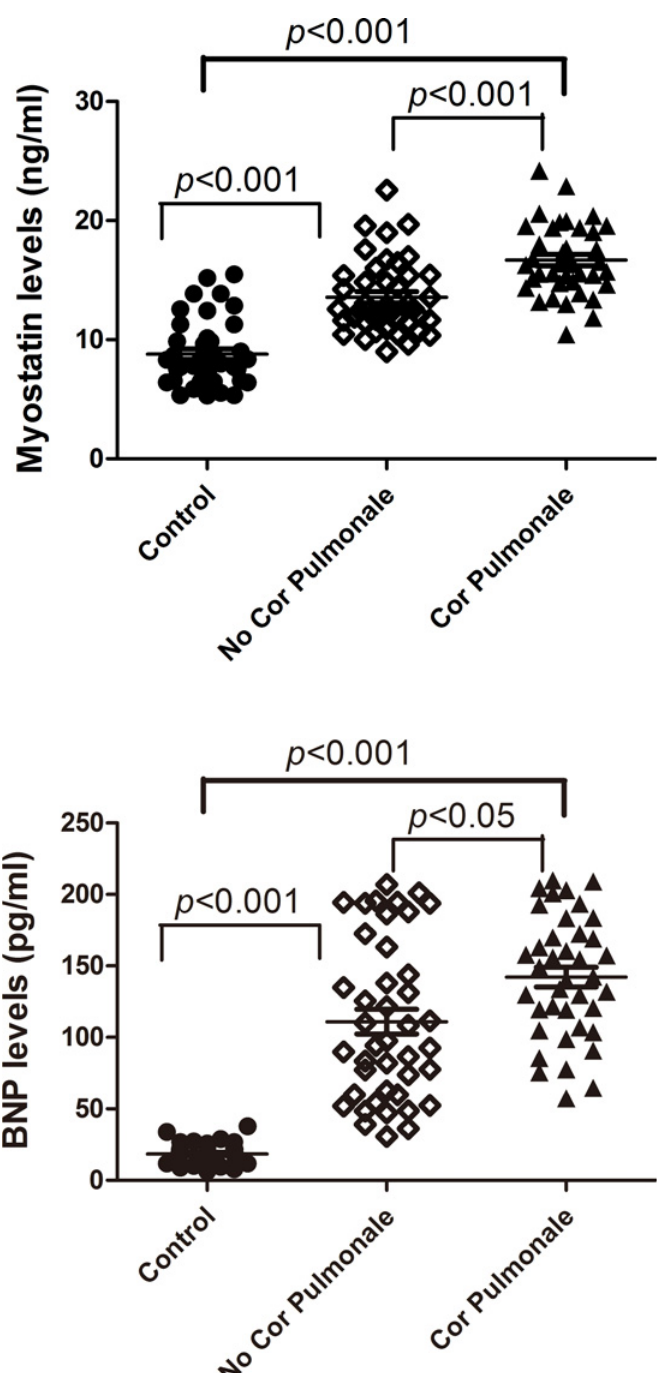
Fig 1. Fig 1(A) and (B). Comparison of myostatin and B-type natriuretic peptide (BNP) levels among the three groups. Circles represent control group, diamonds represent the group without cor pulmonale, and triangles represents the group with cor pulmonale. (A) Significantly higher myostatin levels in group without cor pulmonale, and much higher levels in the group with cor pulmonale, when compared with controls. (B) Significant higher BNP levels in the group without cor pulmonale, and much higher levels in the group with cor pulmonale, when compared with controls.